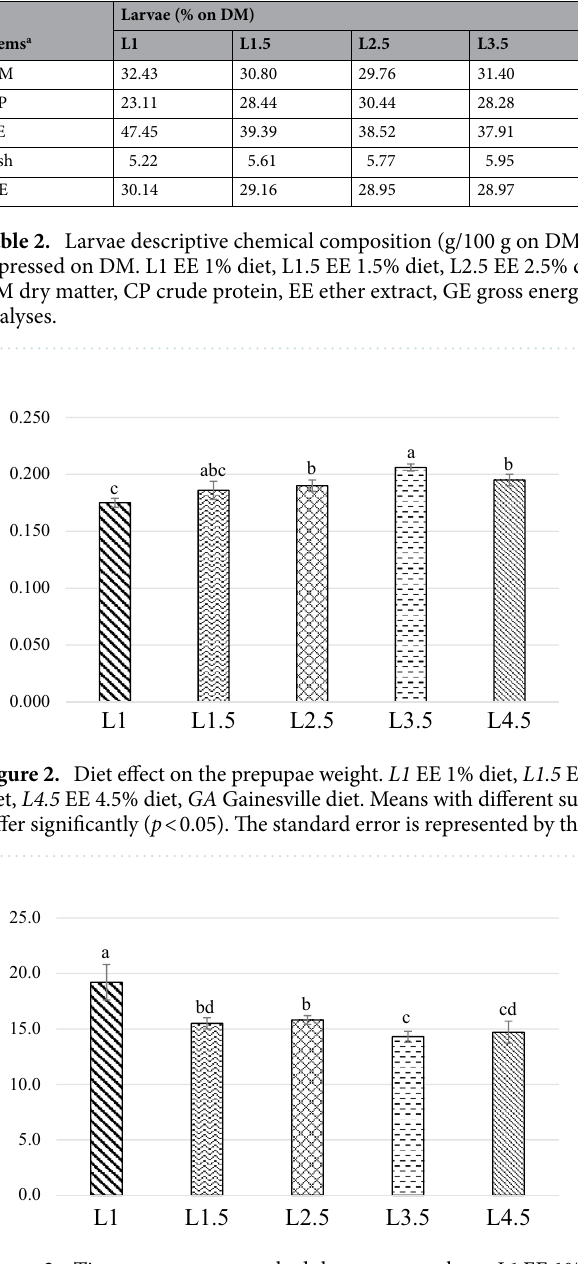
Figure 3. Time necessary to reached the prepupae phase. L1 EE 1% diet, L1.5 EE 1.5% diet, L2.5 EE 2.5% diet, L3.5 EE 3.5% diet, L4.5 EE 4.5% diet, GA Gainesville diet. Means with different superscript letters (a, b, c) within the same row differ significantly ( p < 0.05). The standard error is represented by the error